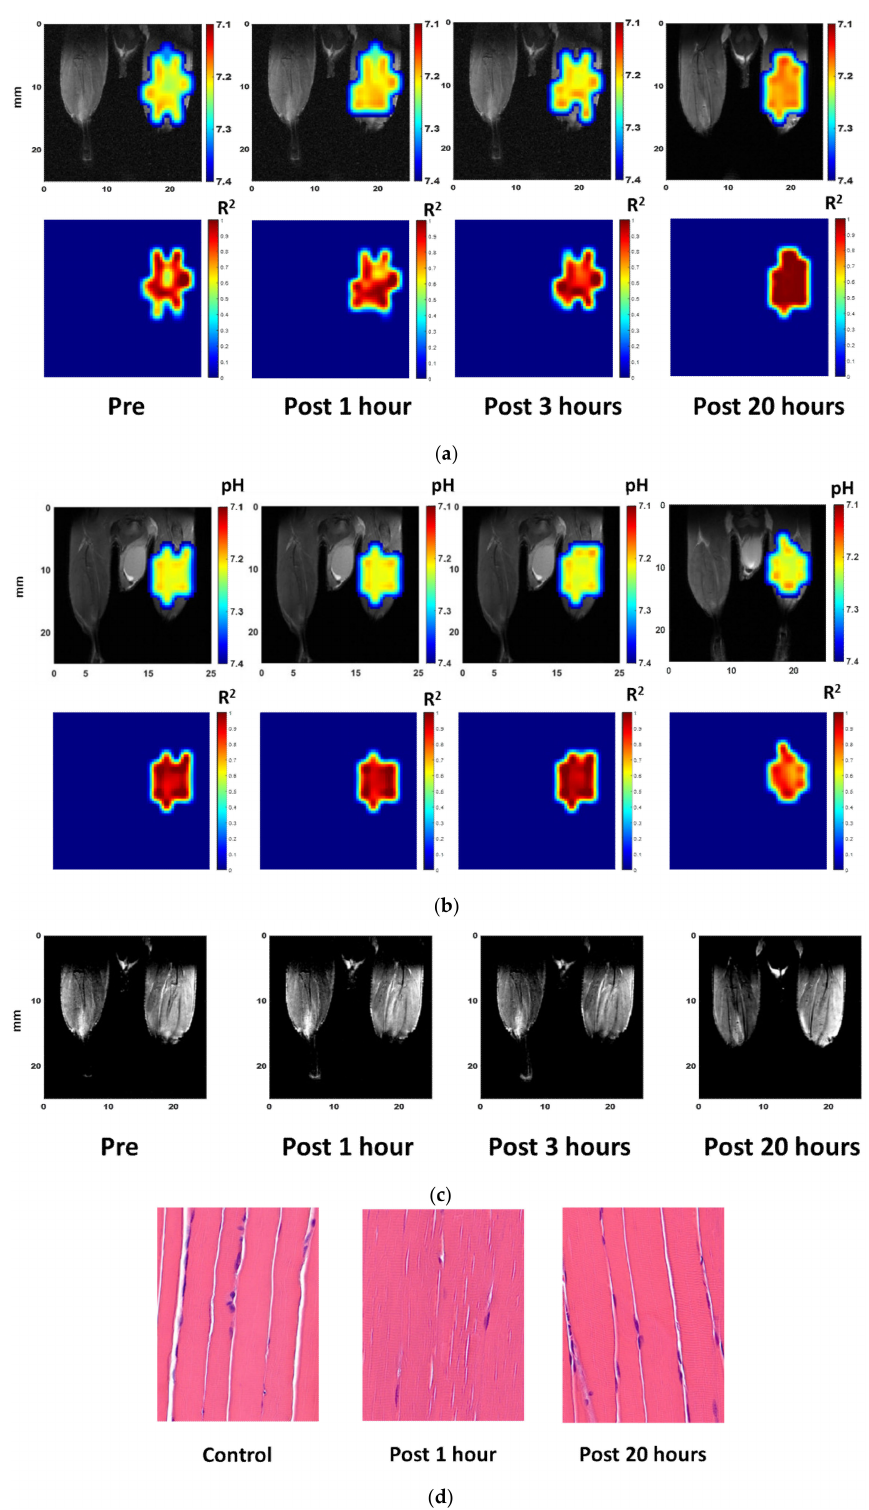
Figure 5. ( a ) The time-dependent pH mapping of the electrically stimulated mouse leg (up) and R 2 mapping (bottom) to show the coe ffi cient of determination of pH mapping. The pH mapping of the control group and the T2WI of the electrically stimulated mouse leg are presented in ( b , c ), respectively, for comparison. The T2WI of the electrically stimulated mouse leg shows only a slightly di ff erence in the gastrocnemius region at 1- and 3-h post-stimulation, and is not distinguishable from the pre-stimulation image after 20 h. ( d ) The pathology of the skeletal muscle of the control group 1 h and 20 h after